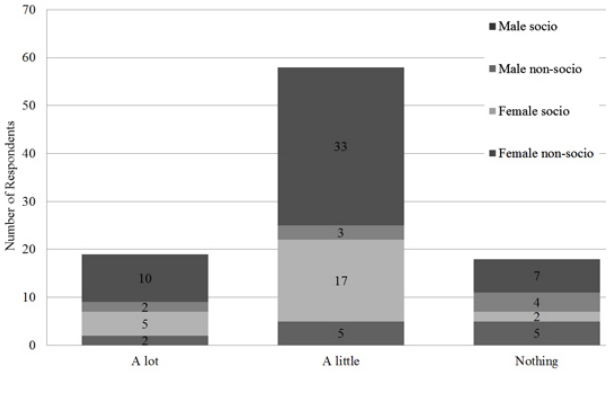
Fig. 2 . Perceived participation in the decision-making about Socio Bosque incentives ( N = 95).